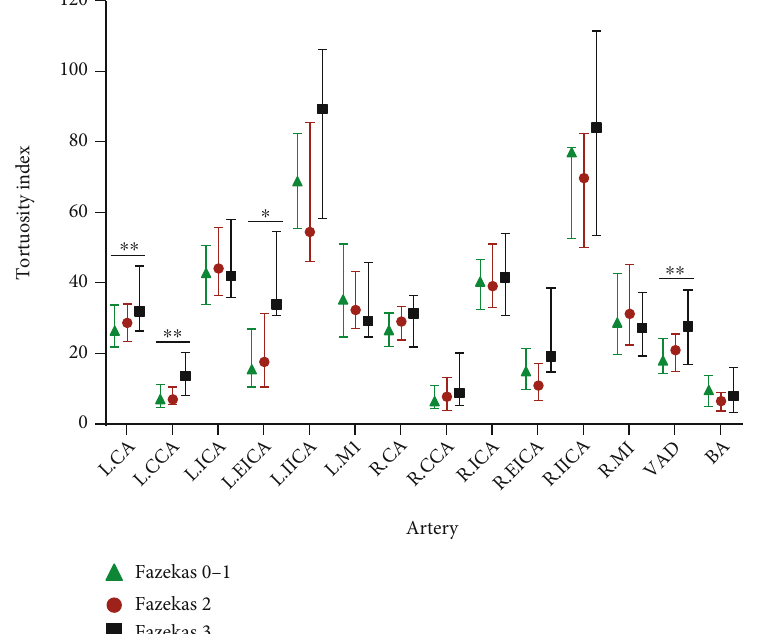
Figure 3: The arterial tortuosity by location in AIS patients and control subjects. AIS: acute ischemic stroke; BA: basilar artery; CA: carotid artery; CCA: common carotid artery; EICA: extracranial internal carotid artery; ICA: internal carotid artery; IICA: intracranial internal carotid artery; L: left; M1: fi rst segment of middle cerebral artery; R: right; VAD, vertebral artery dominance. ∗ P < 0 : 05 (AIS patients versus control); ∗∗ P < 0 : 01 ; and ∗∗∗ P < 0 : 001 .